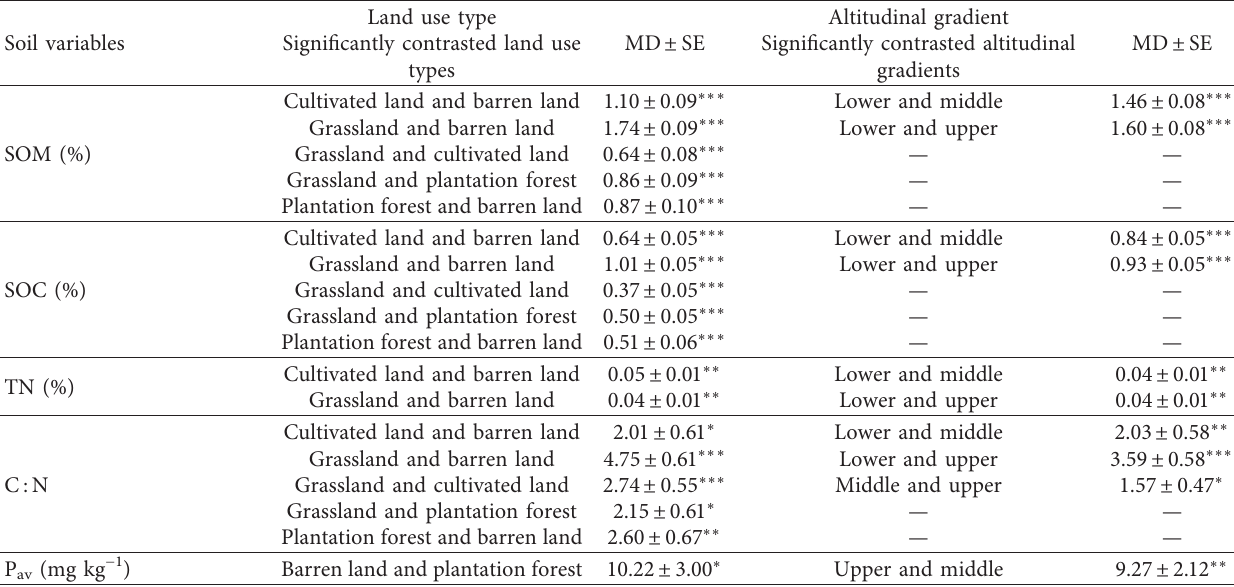
Table 6: Effects of land use types and altitudinal gradients on soil pH (H